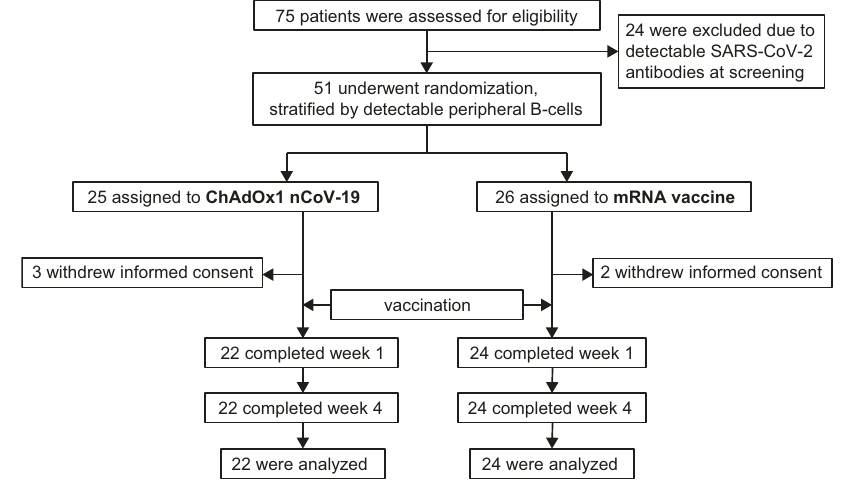
Fig. 1 | Screening, randomization, and follow-up of patients. Patients rando- mized to an additional mRNA vaccine dose received the same compound as with